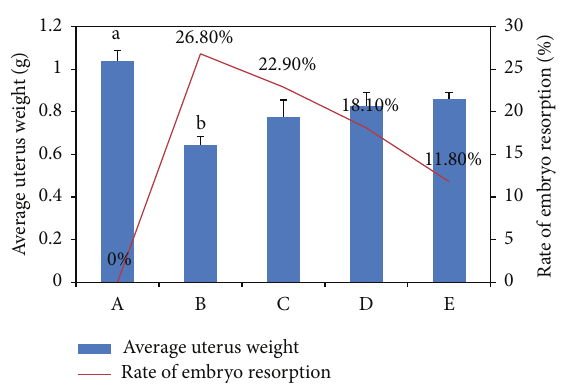
Figure 3: The weight and percentage of resorption: (A) control group, (B) LPS group, (C) 0.25 mg/mL Baicalin, (D) 1.25 mg/mL Baicalin, and (E) 2.5 mg/mL